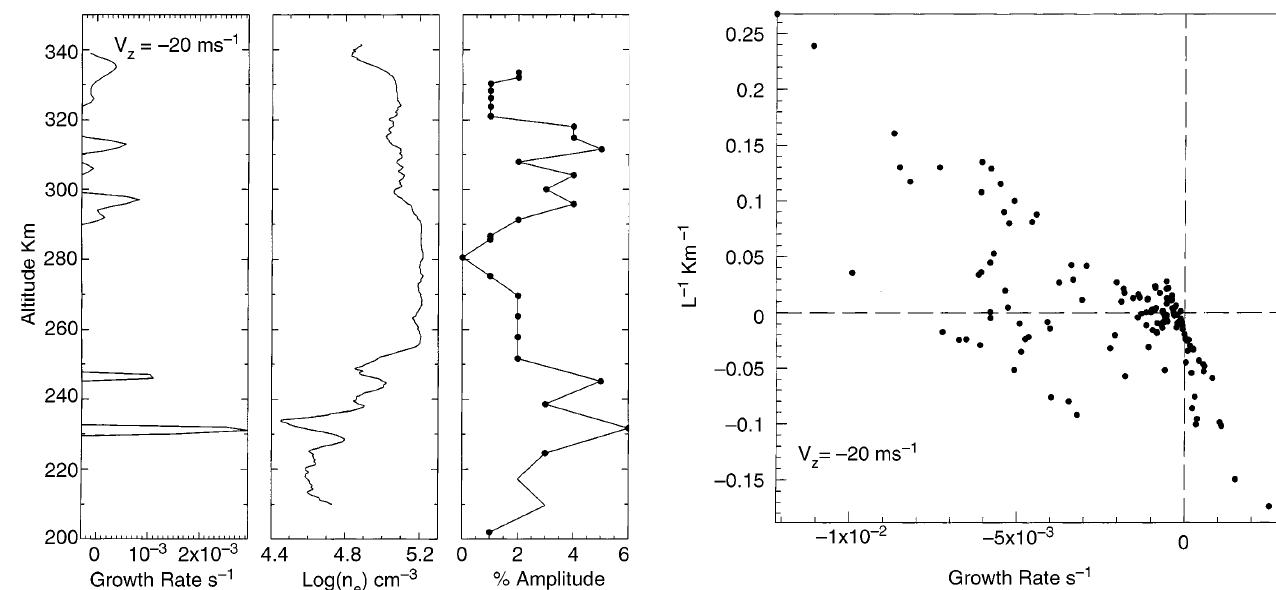
Fig. 4. The altitude variation of linear growth rate of irregularities generated through GRT instability is shown in the first panel , the middle panel shows the electron density profile obtained by taking a 4 km running average of the actual profile during the ascent and the last panel shows the percentage amplitude of the irregularities in the intermediate scale (200 m–2 km)